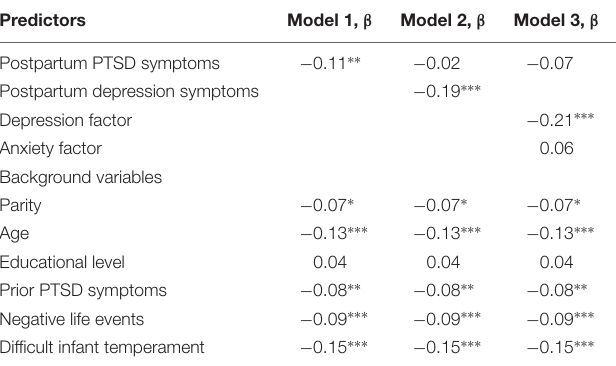
TABLE 3 | Results from structural equation models predicting couple relationship